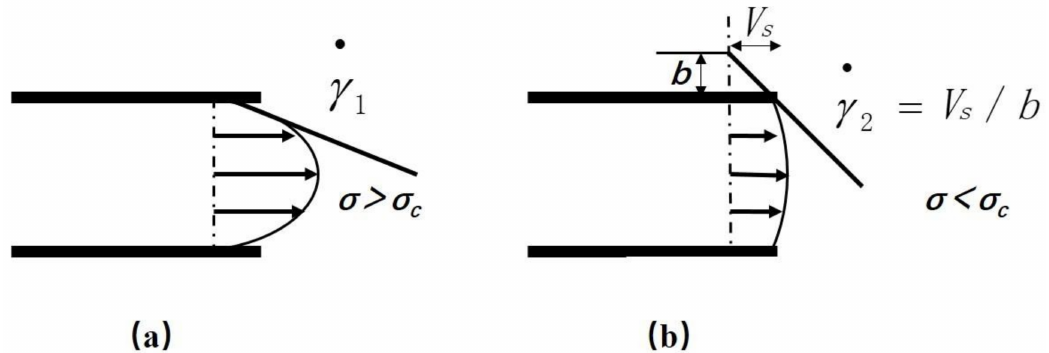
Figure 1. The interface state of fluid dynamics when the polymer shear rate changes at the die exit. ( a ) Viscous state, ( b ) Slip